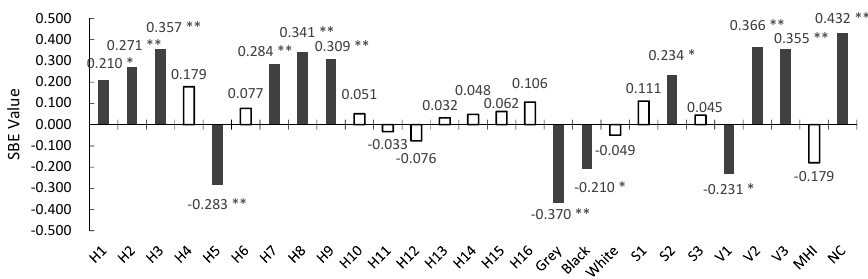
Figure 5. Correlation between color elements and Scenic Beauty Estimation (SBE) values. Note: ** denotes p < 0.01, * denotes p < 0.05.